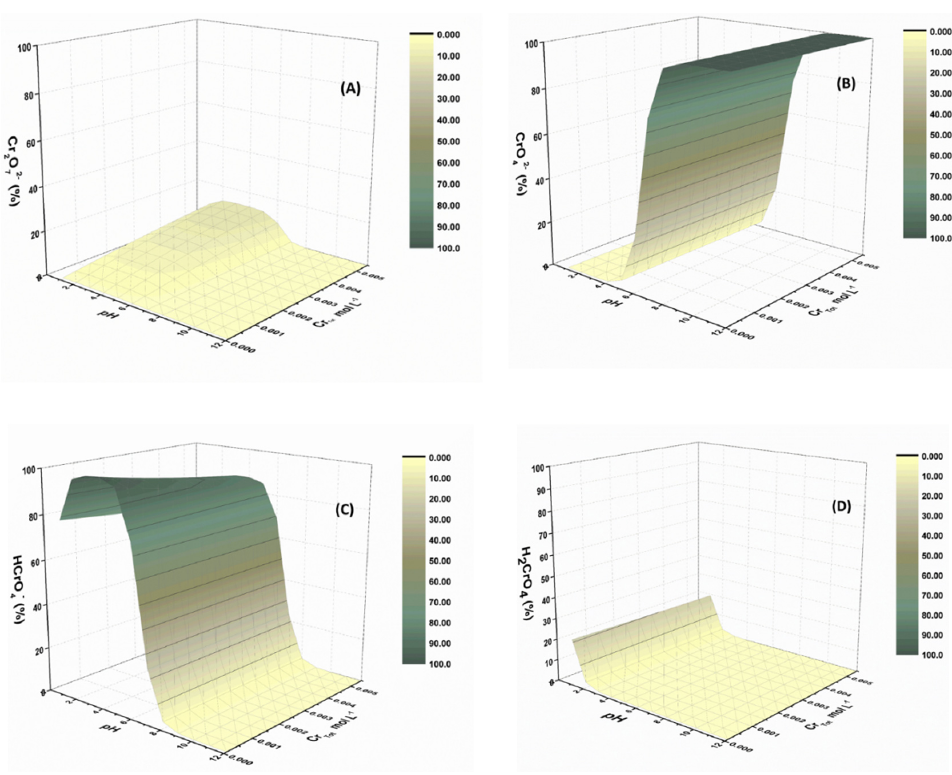
Figure 1. Cr(VI) species distribution (%) as a function of pH and total Cr(VI) concentration: ( A ) Cr 2 O 72 − ; ( B ) CrO 42 − ; ( C ) H 2 CrO 4 ; ( D ) HCrO 4 − .